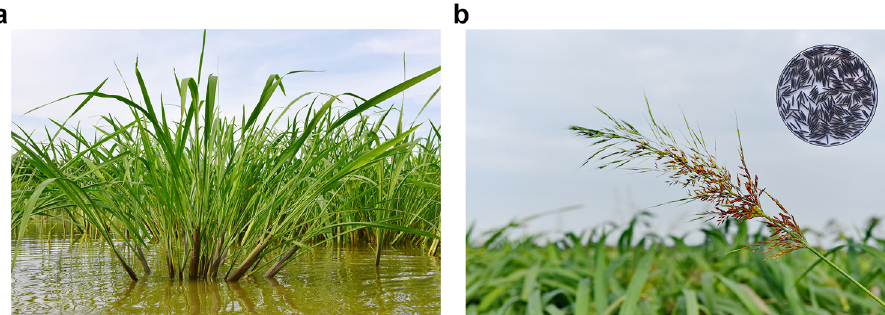
Fig. 1 Photographs of Chinese wild rice plants and in fl orescence with seeds. a Chinese wild rice plants growing in a paddy fi eld. b In fl orescence and seed morphology of Chinese wild rice. The pictures were taken by Ning Yan from Tobacco Research Institute of Chinese Academy of Agricultural